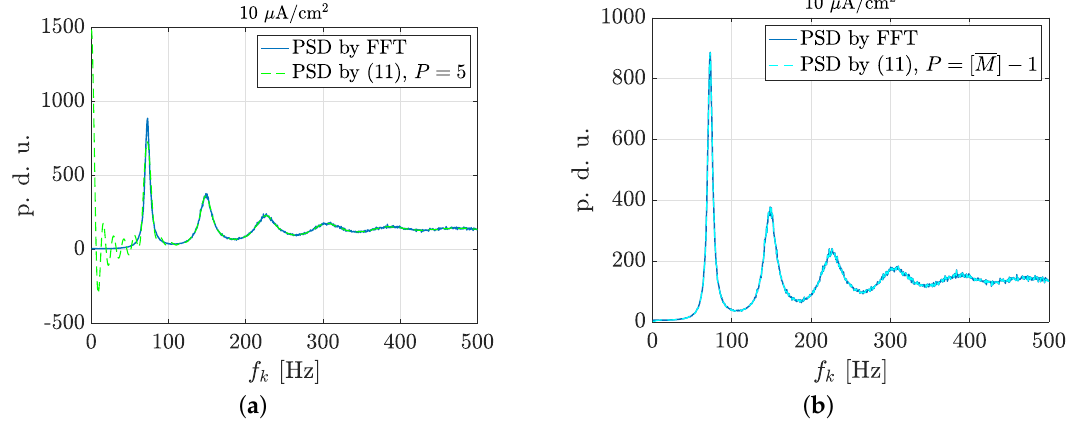
Figure 6. Comparison of power spectra, for I 0 = 10 µA/cm 2 , patch = 100 µm 2 , obtained by means of FFT (blue solid line) and (12) with ( a ) P = 5 (green dashed line) and ( b ) P = [ M ] − 1 = 138 (cyan dashed